Question: Does the figure show an increasing or a decreasing trend?
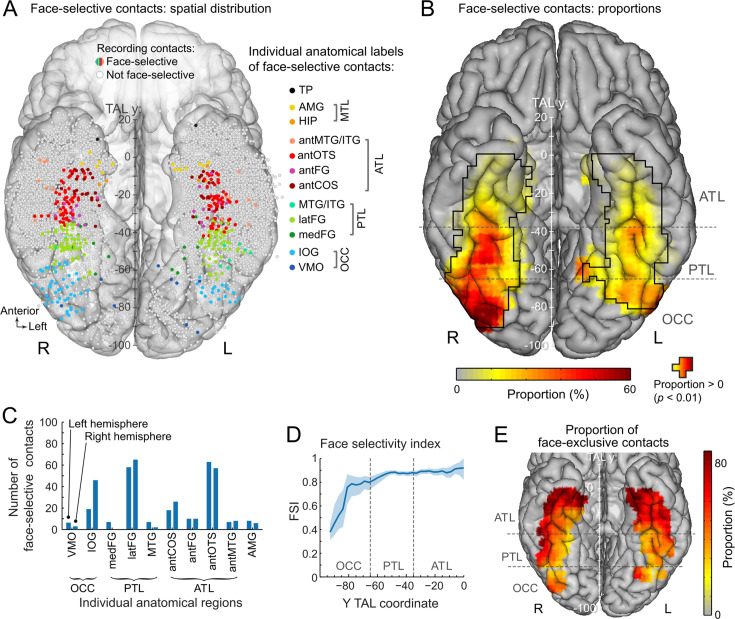
Answer: increasing